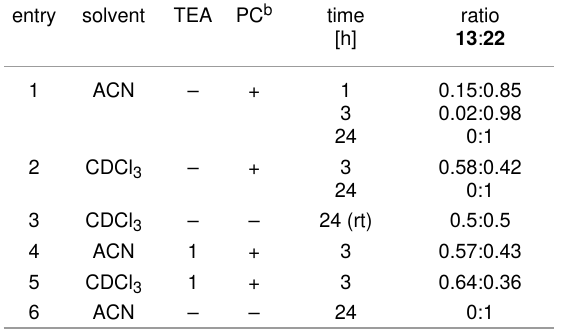
Table 3: Studies on the reactivity of 13 in the presence of BTMS.